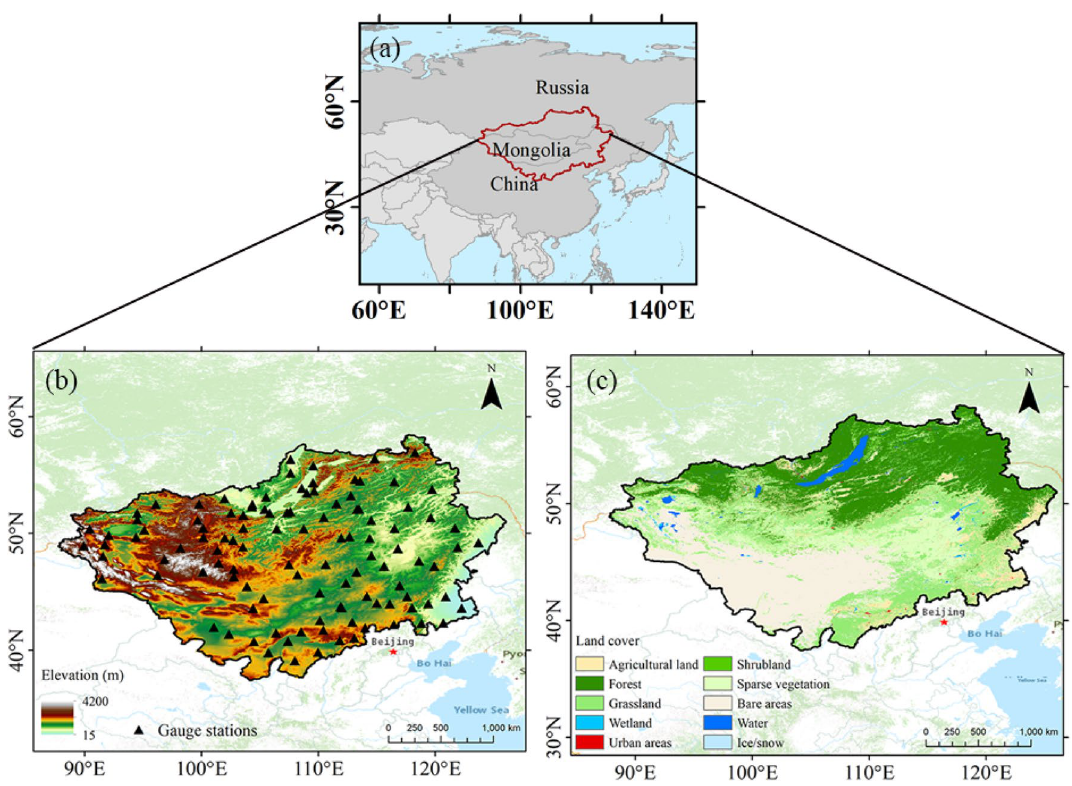
Figure 1. The ( a ) location, ( b ) topography and positions of the rain gauge stations, and ( c ) land cover of the Mongolian Plateau. The figure was created using ArcGIS 10.7 (https:// www. esri. com/ en- us/ arcgis/ about- arcgis/ overv iew) 70